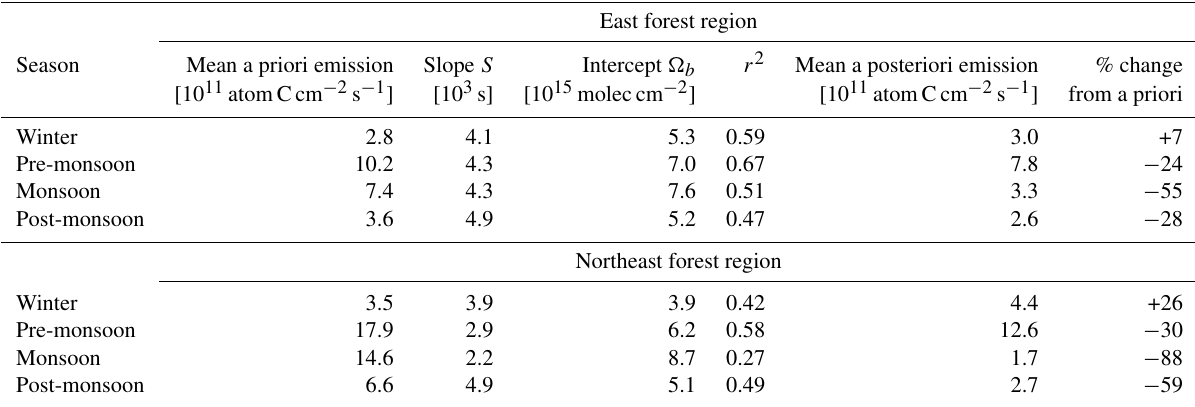
Table 3. A priori and a posteriori isoprene emission estimates (10 11 atomCcm − 2 s − 1 ) over NE and E forest sites (Fig. 1), and the model linear regression coefficients that relate model isoprene emissions and HCHO